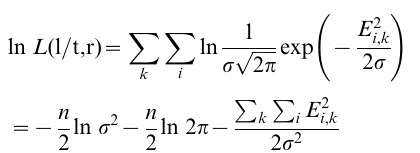
Figure S1 MC and UPM optimization of the supertree branch lengths. (PDF) Figure S2 Distribution of the D AIC values for 1000 bootstrap samples (the curve was obtained by Gaussian-kernel smoothing of the individual data points). The red line indicates the D AIC value for the original set of GTs (1310.8). (PDF) Figure S3 A: Relative goodness of fit for the UPM vs the MC model ( dfit ) plotted against the fraction of original GT leaves retained in MAST ( mg ). B: Relative goodness of fit for the UPM vs the MC model (dfit) plotted against the average goodness of fit (afit). C: Relative goodness of fit for the UPM vs the MC model (dfit) plotted against the relative evolution rate (r).C. (PDF) Text S1 Supertree (ST 3 ) topology (Newick